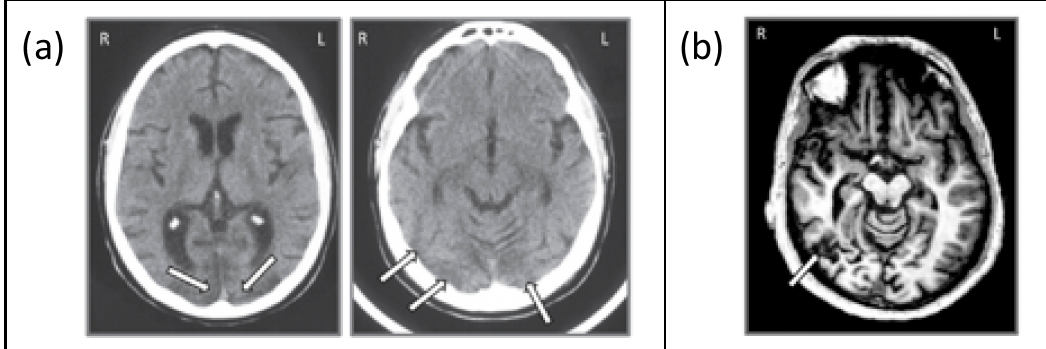
Figure 3. ( a ) Axial slice from the CT scan of JW showing bilateral posterior damage to parts of V1 and V2 and ( b ) axial slice from the MRI scan of SM showing lateralized damage to the right inferior temporal lobe. Adapted from Freud et al. [8], with permission from Oxford University Press, 2018.